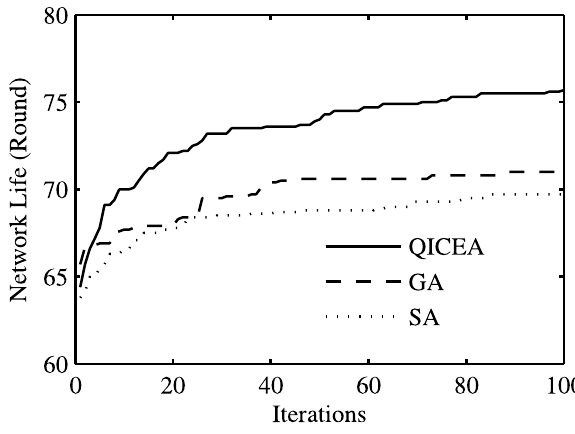
Figure 1: The network lifetime with 10 targets and 55 sensors..